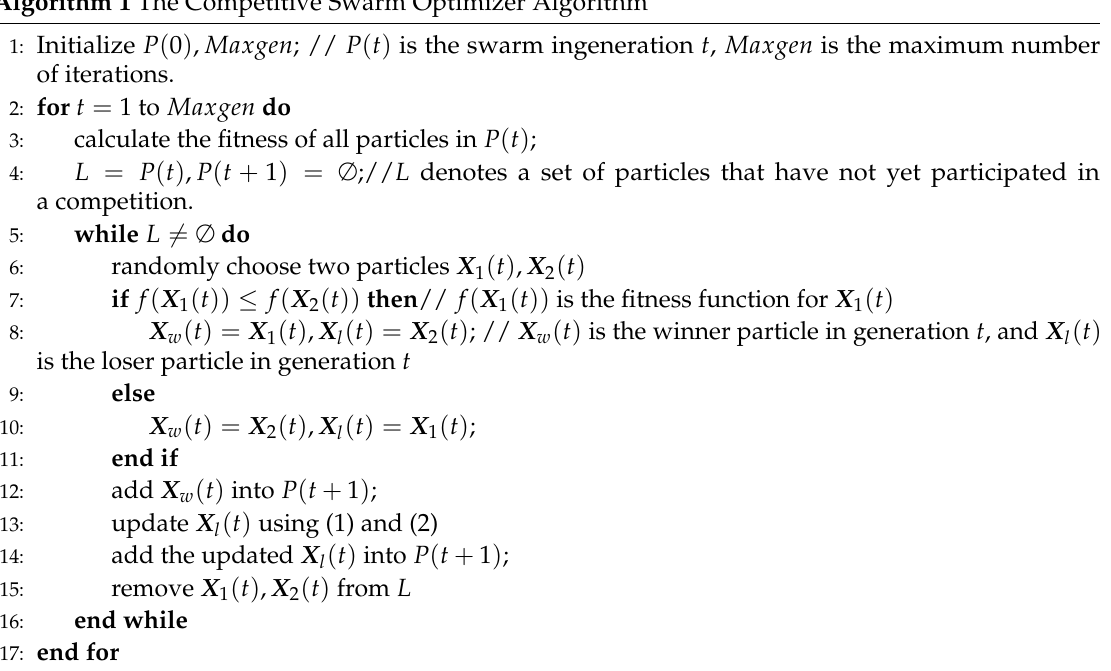
Algorithm 1 The Competitive Swarm Optimizer